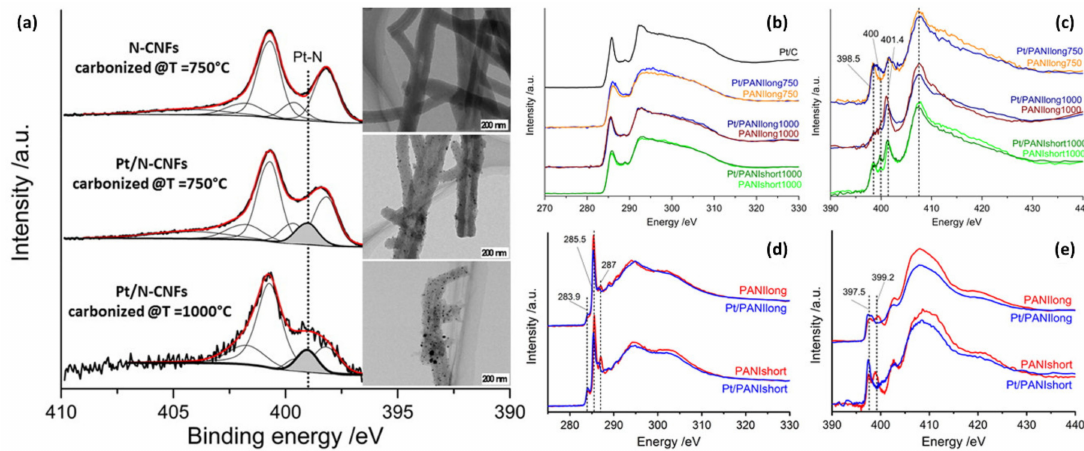
Figure 16. ( a ) XPS spectra and TEM images, and near-edge X-ray absorption fine structure (NEXAFS) spectra of ( b and d ) C(1s) K-edge, ( c and e ) N(1s) K-edge nanofiber samples made from PANI. (Reproduced with permission from Reference [126]; Copyright (2016) American Chemical